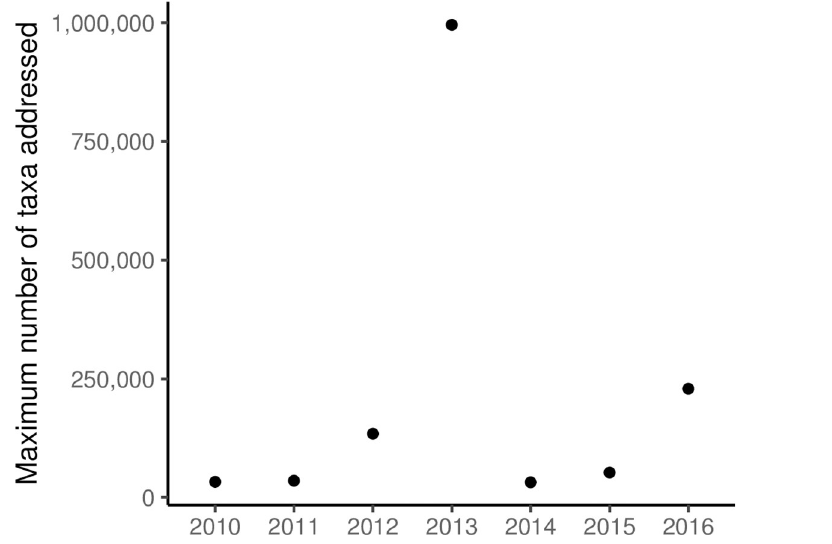
Fig 5. Maximum number of taxa addressed in papers ( n = 501) from 2010–2016.